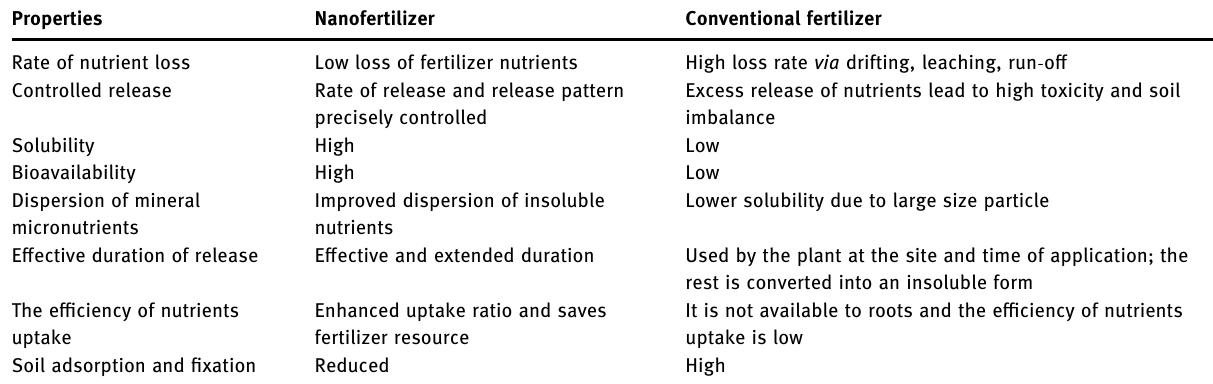
Table 1: The di ff erence between conventional fertilizers and nanofertilizers